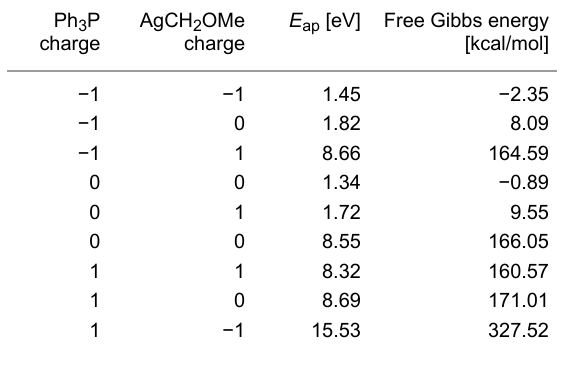
Table 6: Appearance energy (Equation 2) and free Gibbs energy of differently charged Ph 3 P and AgCH 2 OMe fragments from dissociation of [AgCH 2 OMe(PPh 3 )].